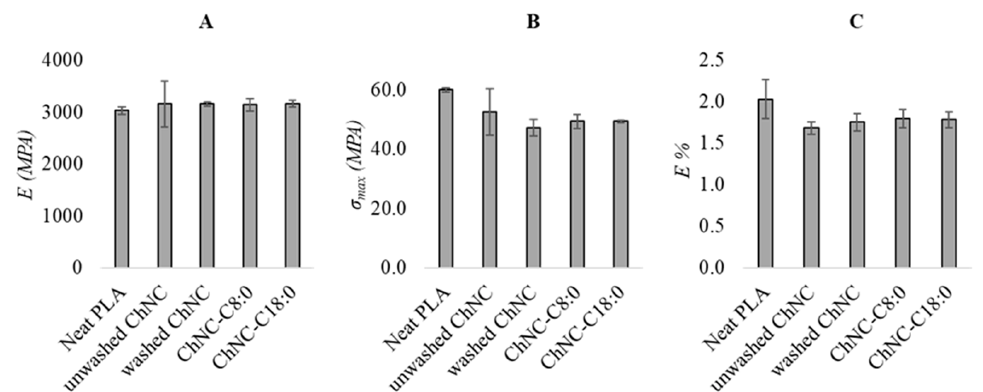
Figure 8. Young’s modulus ( A ), maximum stress ( B ), and elongation at break ( C ) of neat PLA and nanocomposites containing unmodified (unwashed and washed) and modified chitin nanocrystals (ChNC-C8:0 and ChNC-C18:0).